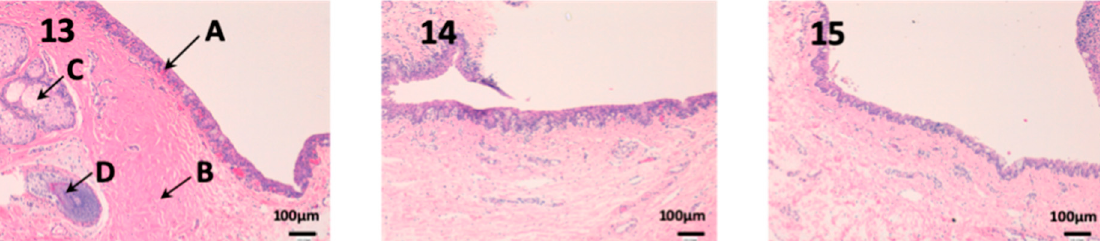
Figure 12. Photo 13: Histological image of untreated conjunctive mucous observed at 400× ; Photo 14: Histological image of conjunctive mucous treated with CP-Solution observed at 400× ; Photo 15: Histological image of conjunctive mucous treated with CP-NPs observed at 400× . (A) Stratified flat keratinized epithelium; (B) own laminate. (C) oil gland and (D) hair Follicle.